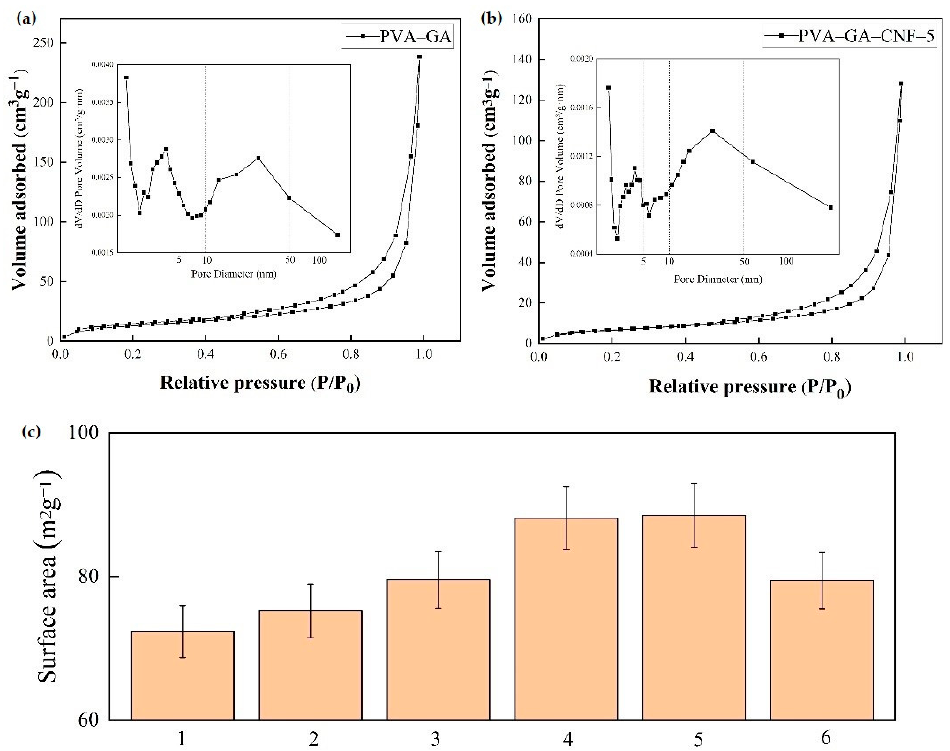
Figure 4. Pore size distribution and specific surface area of composite aerogels. ( a , b ) BET diagrams of PVA–GA and PVA–GA–CNF-5 aerogels, respectively. ( c ) Specific surface areas of PVA–GA and PVA–GA–CNF ‐ (1, 2, 3 , 4, 5) aerogels.